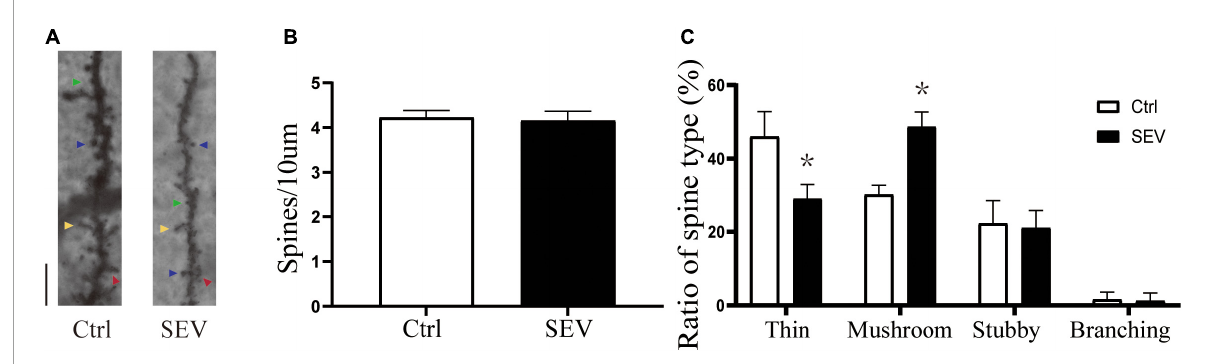
FIGURE2 Sevoflurane can alert the proportions of the dendritic spines. (A) Representative images of Golgi staining of dendritic spines in the hippocampi of PND 14 mice. Different spine types are indicated by relevant color arrowheads: thin spine (yellow), mushroom spine (blue), stubby spine (green), branching spine (red). Scale bar = 10 µ m. (B,C) The quantitative analysis of spine density and proportions of spine types by one-way ANOVA. Results are the means ± SD, n = 6 mice per group. * P < 0.05 vs. Ctrl.